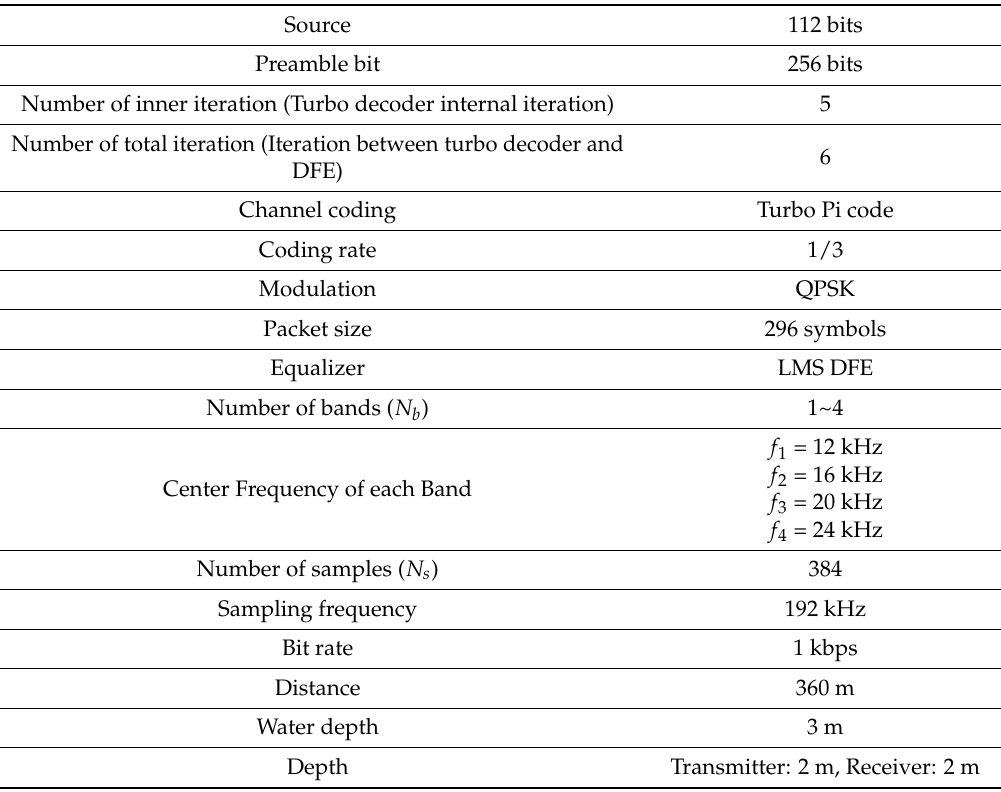
Table 1. Experimental parameters.